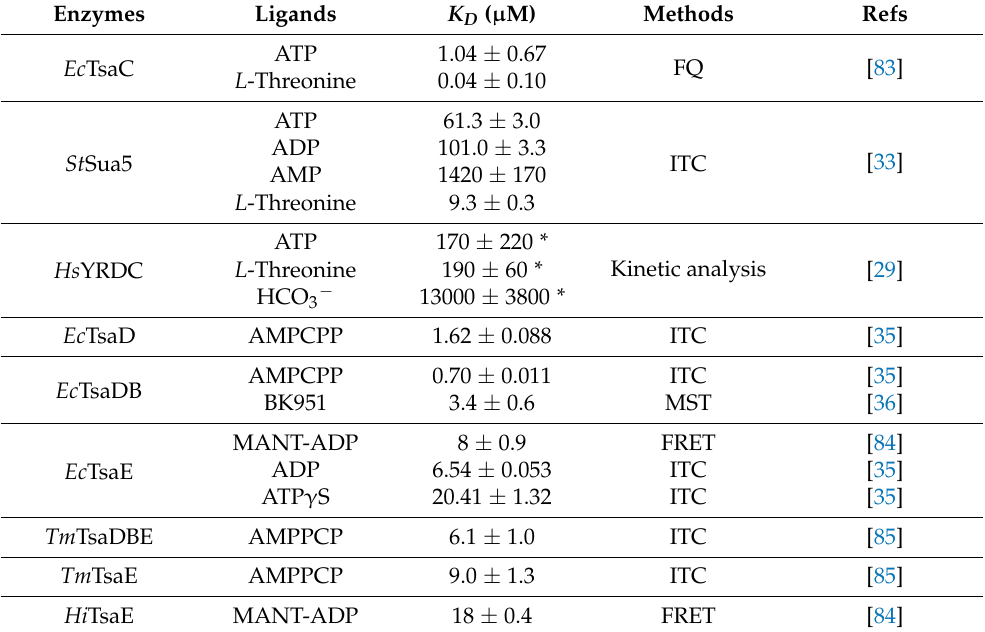
Table 2. Summary of the binding between the t 6 A-modifying enzymes and ligands. Abbreviations: Ec , Escherichia coli ; St , Sulfolobus tokodaii ; Tm , Thermotoga maritima ; Hi , Haemophilus influenzae ; Hs , H. sapiens ; FQ, fluorescence quenching; ITC, isothermal titration calorimetry; MST, microscale thermophoresis; FRET, fluorescence resonance energy transfer; TsaBD, TsaD–TsaB; TsaDBE, TsaD–TsaB–TsaE; *, K M values. Enzymes Ligands K D ( µ